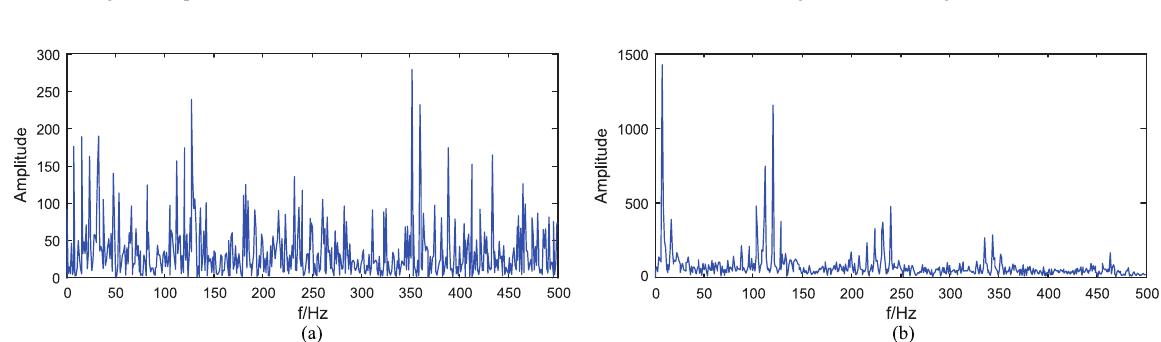
Fig. 3. Comprehensive fault simulation test bench. Fig. 4. Gears fault signal.